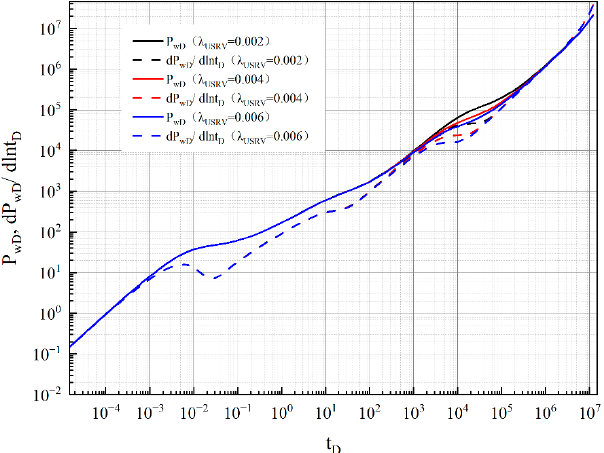
Figure 15. The effect of the USRV inter-porosity coefficient on the pressure response.